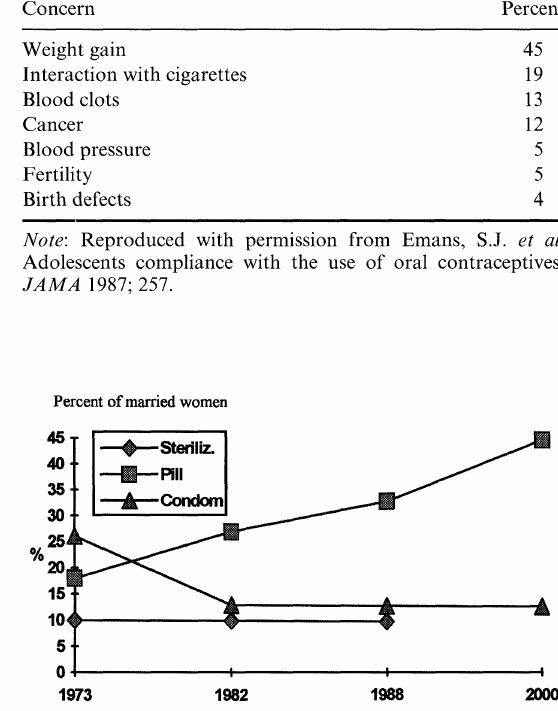
TABLE III Worldwide prevalence* of specific contraceptive methods in 1983 and 1987